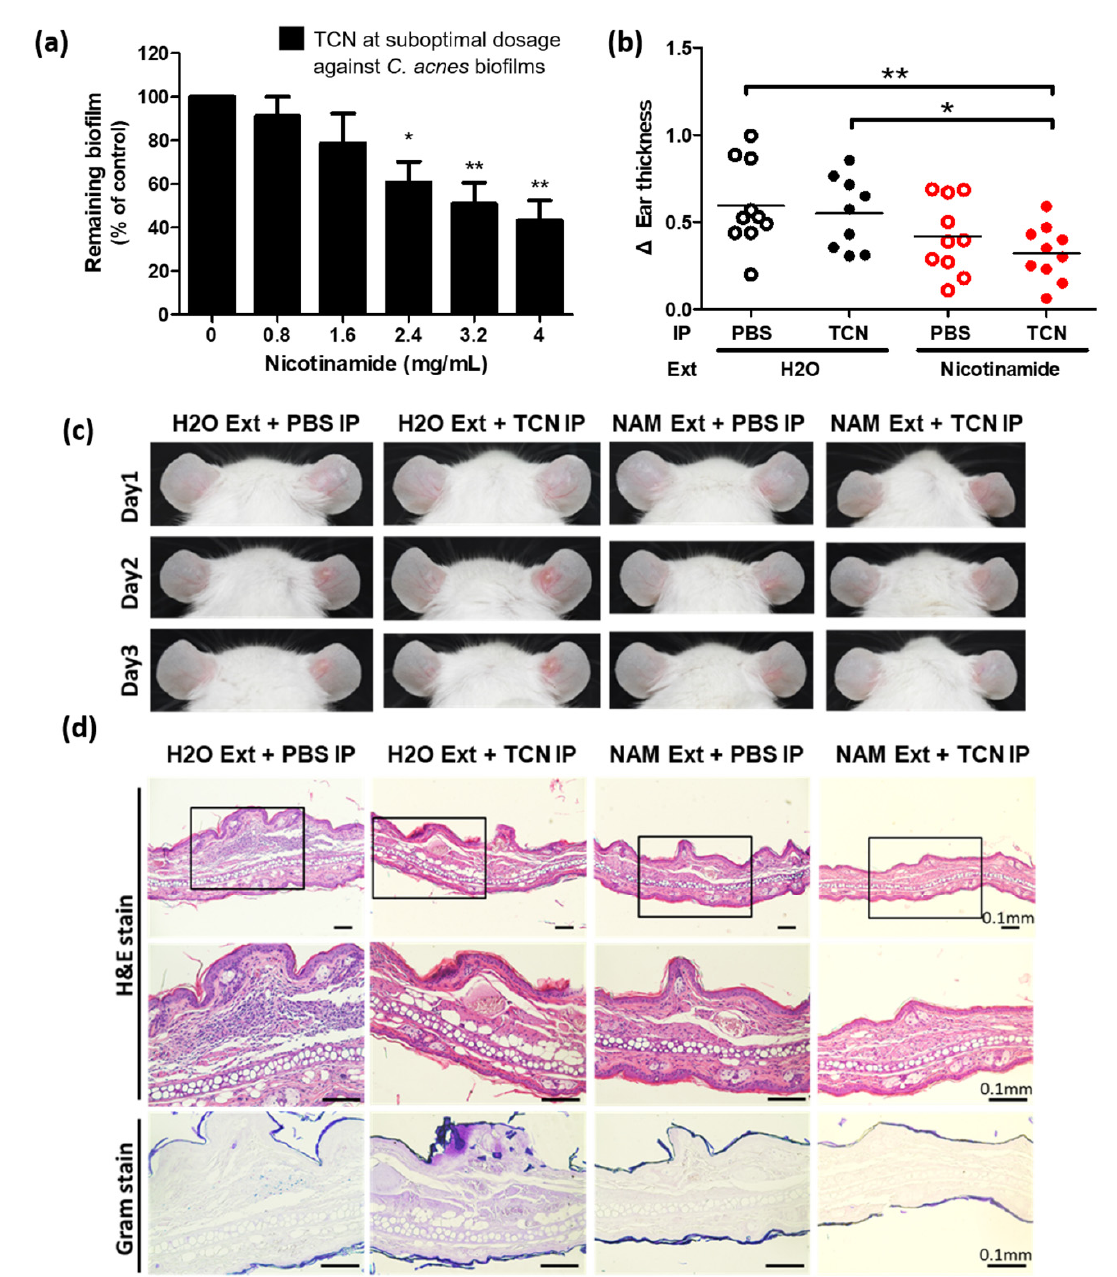
Figure 2. Nicotinamide (NAM) potentiates the efficacy of a suboptimal dose of tetracycline (TCN) against Cutibacterium ( C. ) acnes . ( a ) The biofilm of C. acnes was treated with a combination of TCN and NAM at indicated dosages in vitro. Note that the dosage of TCN (1.2 mg/L) was suboptimal to reduce the biofilm by 50% (see Figure 1b). n = 4 (mean ± SEM, * p < 0.05, ** p < 0.01). ( b ) Mice inoculated with C. acnes were treated with combinations of topical NAM and/or intraperitoneal TCN. IP, intraperitoneal injection; Ext, external application; PBS, phosphate-buffered saline; H 2 O, distilled water. The difference in ear thickness on day 3 was analyzed; n = 10 in each group (Each dot represents data from a mouse within each group. The horizontal line shows the mean of each group, * p < 0.05, ** p < 0.01) ( c ) Representative images showing the response of the ears to each treatment for 3 days. ( d ) Histology with hematoxylin and eosin staining and Gram staining demonstrating the swelling, inflammatory infiltration, and abscess formation of the lesional ears on day 3. Original magnification, upper row, 100 × ; middle and lower rows, 200 × . Scale bar = 0.1 mm.